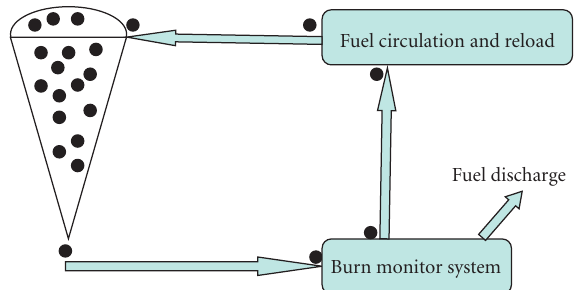
Figure 4: The multipass MPBR of fuel